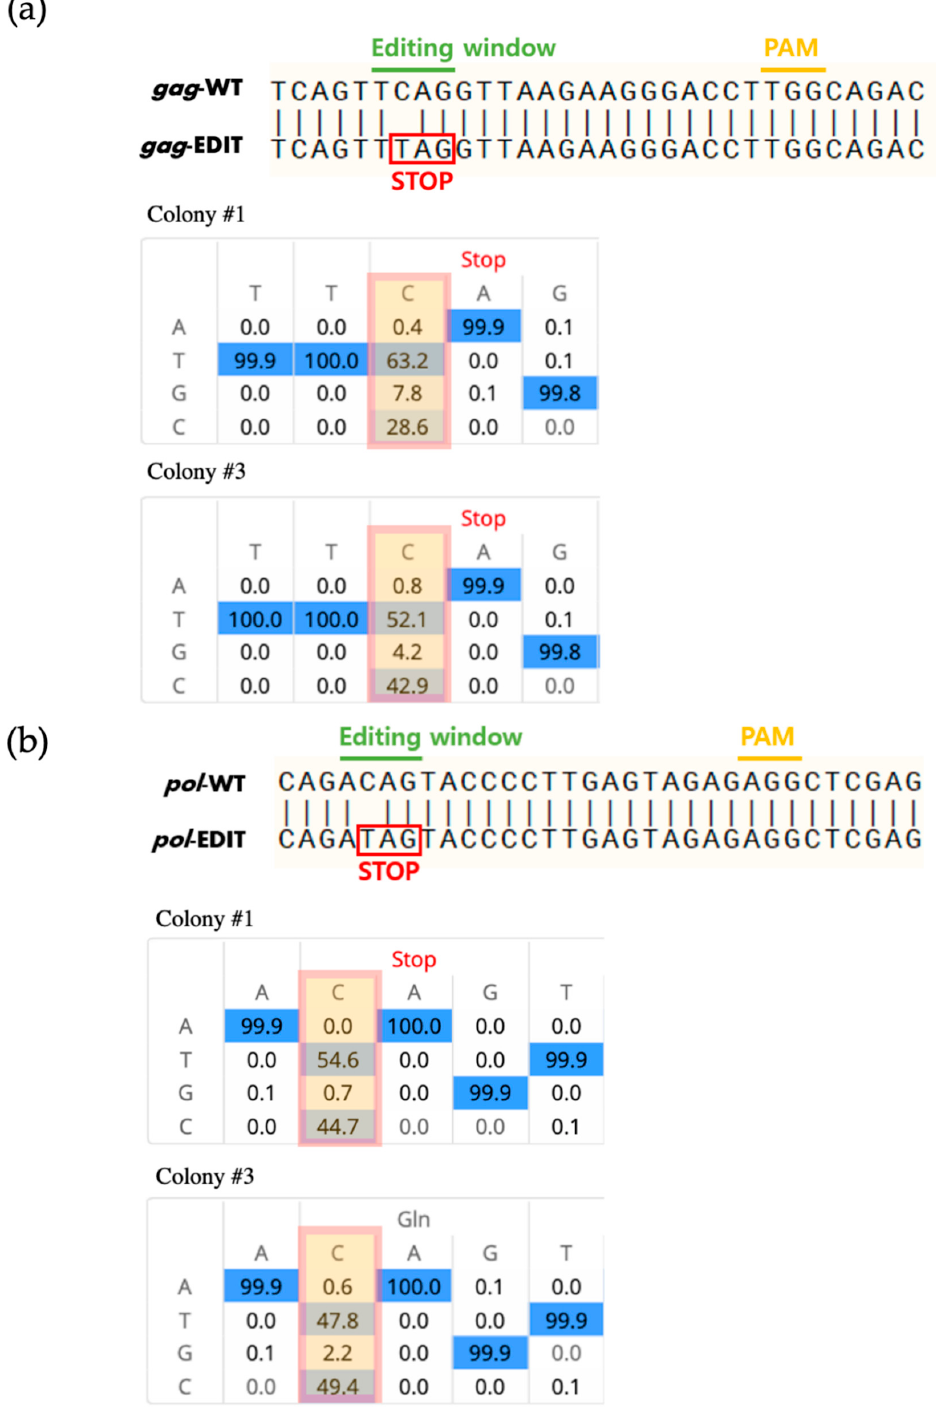
Figure 2. Base edited results at the target locus of Target-AID. ( a ) Sequence alignment of gag from wild-type and edited cell lines. ( b ) Sequence alignment of pol from wild-type and edited cell